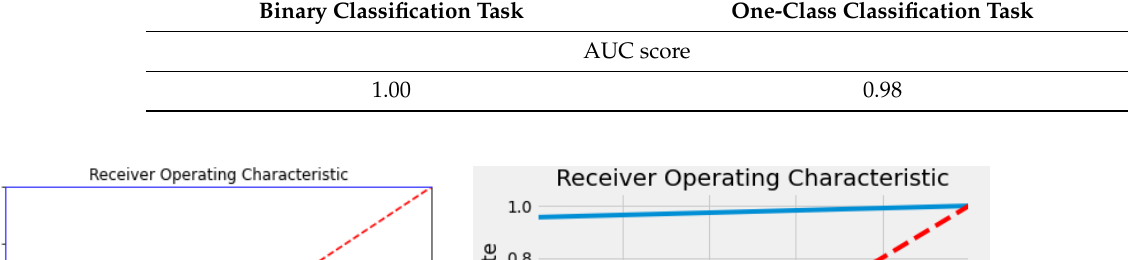
Table 3. Evaluation of CNN prediction accuracy for both tasks. Binary Classification Task